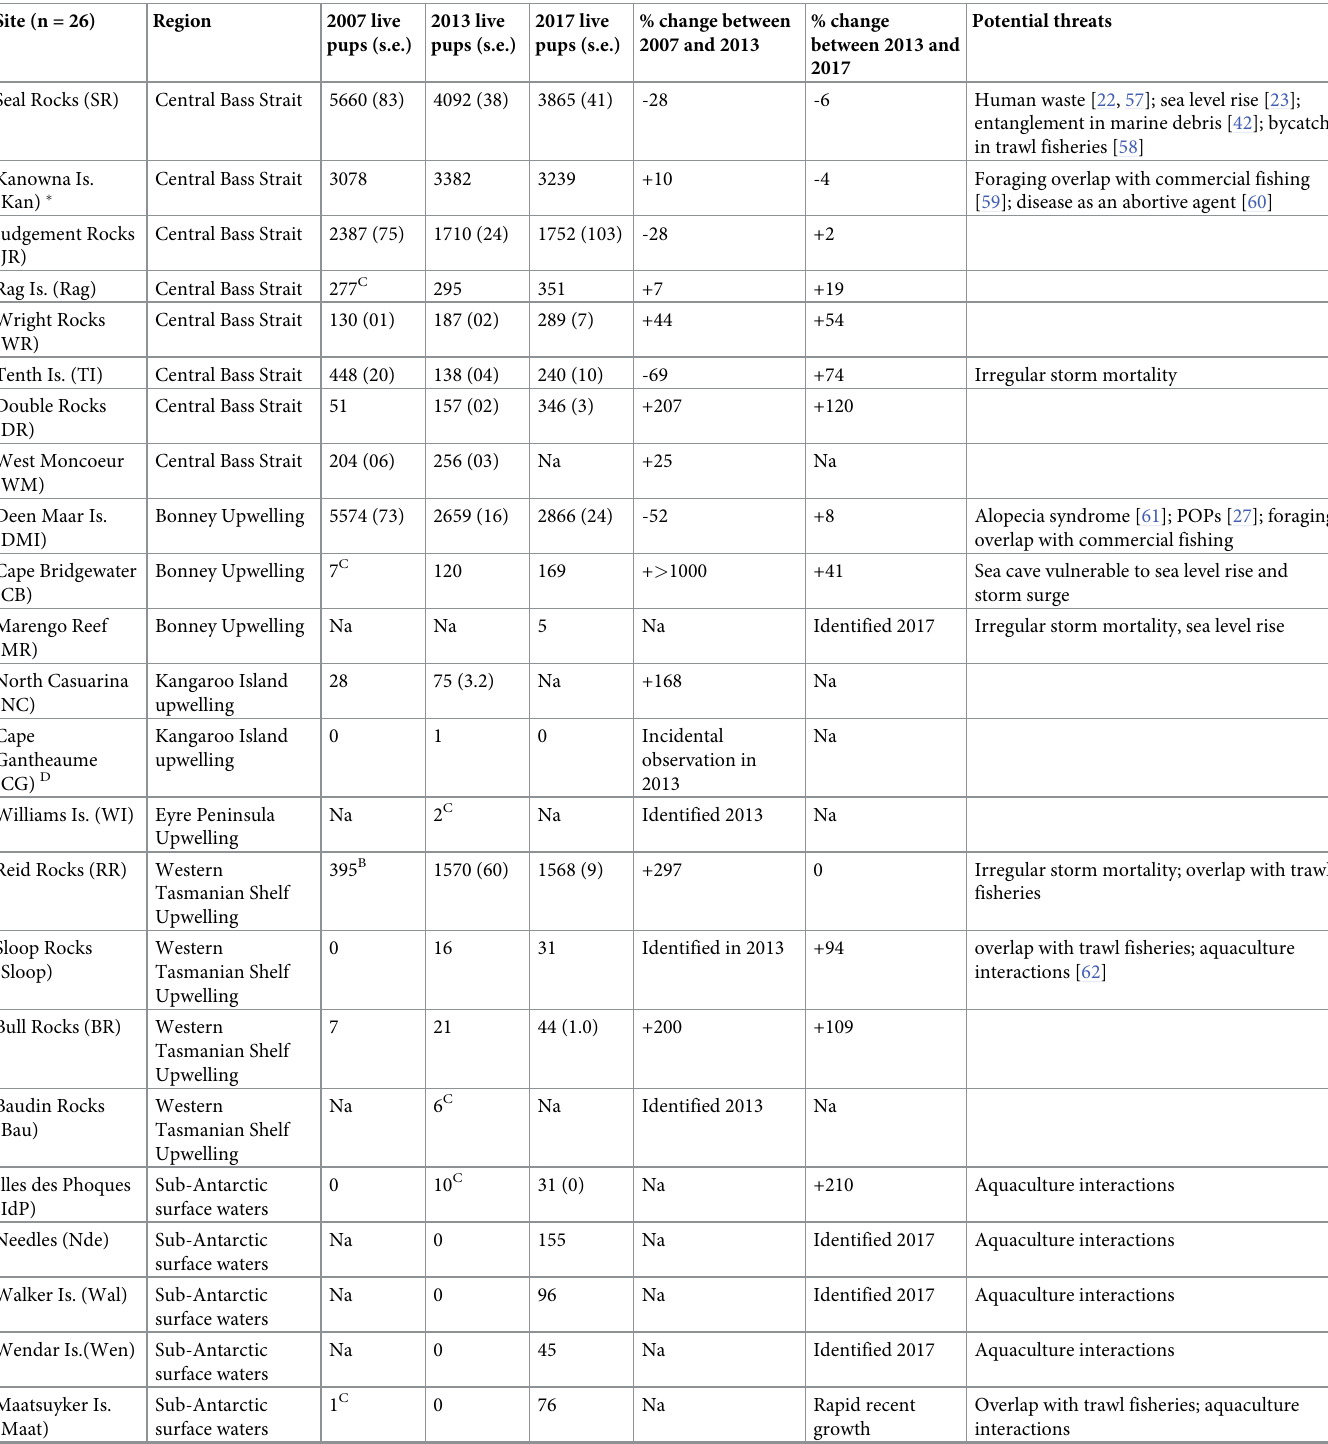
Table 2. Results of the 2007, 2013 and 2017 Australian fur seal censuses for comparison, grouped by regional oceanographic position or influence (Fig 1) and ordered by maximum negative % change to maximum positive % change between 2013 and 2017, followed by sites without data. The % change of estimated live pup numbers between censuses (2007–2013 and 2013–2017) are presented. Seven recently established sites were identified with pups in 2017 and 2013 and therefore have too few data points for trend analysis. The potential threats were obtained from the references provided at the first mention. Site (n =